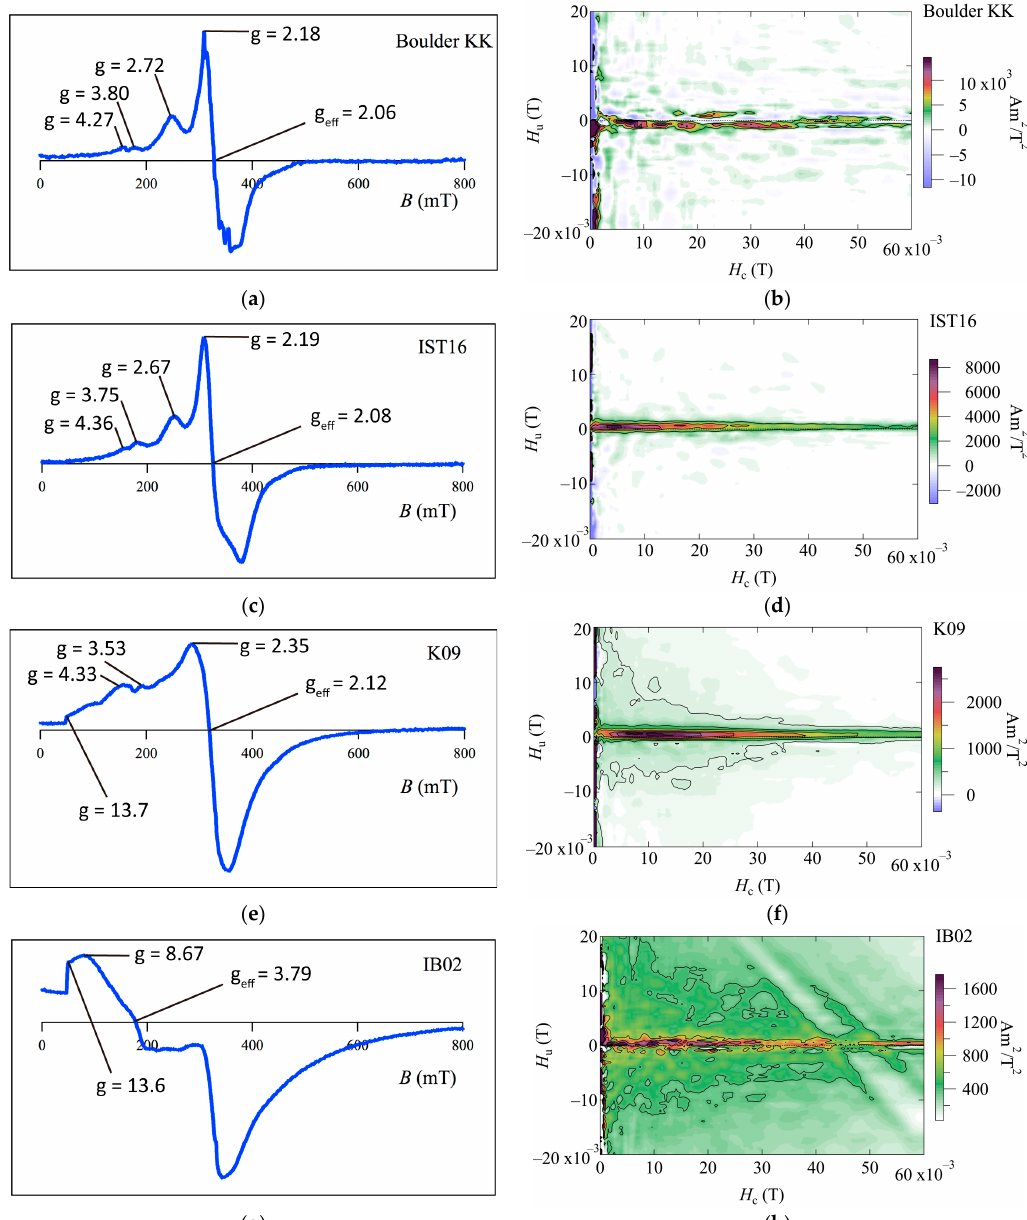
Figure 3. FMR derivative spectra and FORC diagrams of coral boulders on Ishigaki Island; ( a , b ) Boulder KK; ( c , d ) IST 16; ( e , f ) K09; and ( g , h ) IB02. Table 2. Summary of FMR data and parameters from four measured FE-SEM observations of Boulder KK and K09 indicate the existence of rectangular-shaped iron oxide grains in the coral skeletons (Figure 4a). The sizes of the grains are around 100 nm, with most of the grains composing magnetosomes having grain sizes of between ~40 and ~150 nm [32]. The existence of a very short chain of iron oxide grains was also observed in K09 (Figure 4b), suggesting